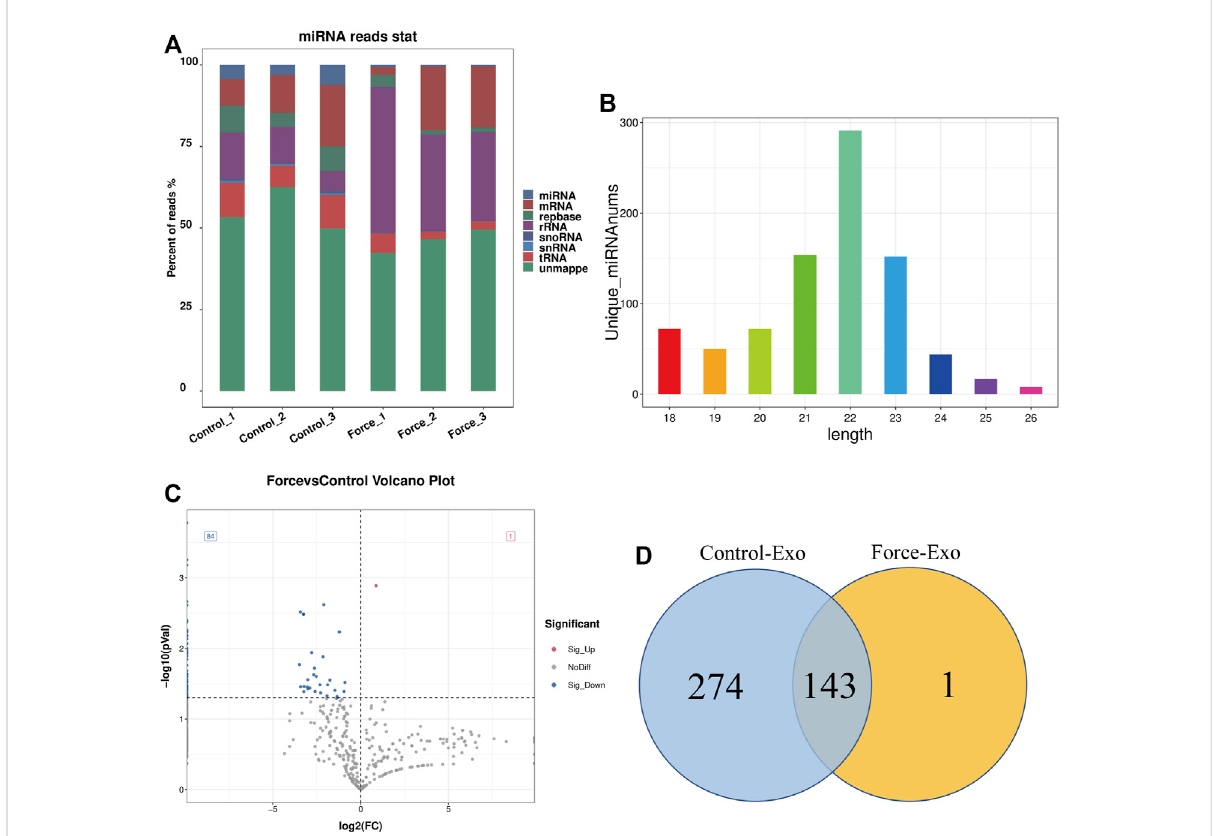
FIGURE 3 Force-Exo and Control-Exo group miRNA expression pro fi les. (A) Classi fi cation of known miRNA genes according to genomic origin. (B) Sequence length distribution of all miRNAs (C) miRNA expression differences between Force-Exo and Control-Exo groups displayed through a volcano plot. Genes presented as grey dots exhibited non-signi fi cantly differential expression between the two MCC-Exo groups, genes presented as red dots exhibited signi fi cant up-regulation in the Force-Exo group compared to the Control-Exo group, and genes presented as blue dots exhibited signi fi cant down-regulation in the Force-Exo group compared to the Control-Exo group. (D) Venn diagram showing the number of miRNAs unique to and common between the Force-Exo and Control-Exo